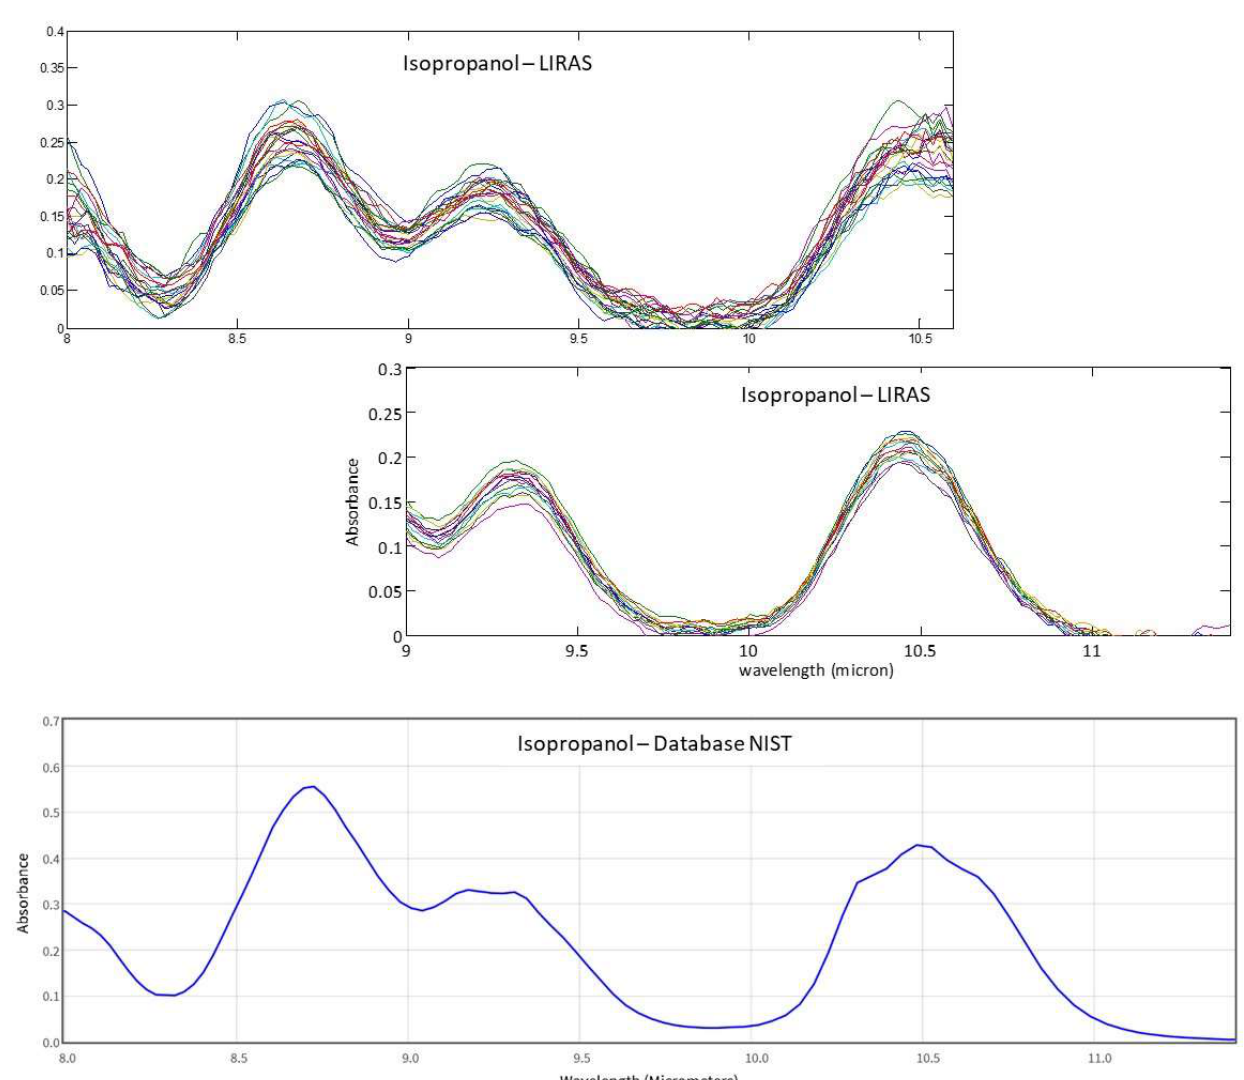
Figure 15. IR absorption spectra of isopropanol measured with the LIRAS sensor tuned at different spectral ranges and the corresponding cumulative reference spectrum from NIST database. Table 8. Benchmarking of the LIRAS sensor with COTS detectors.